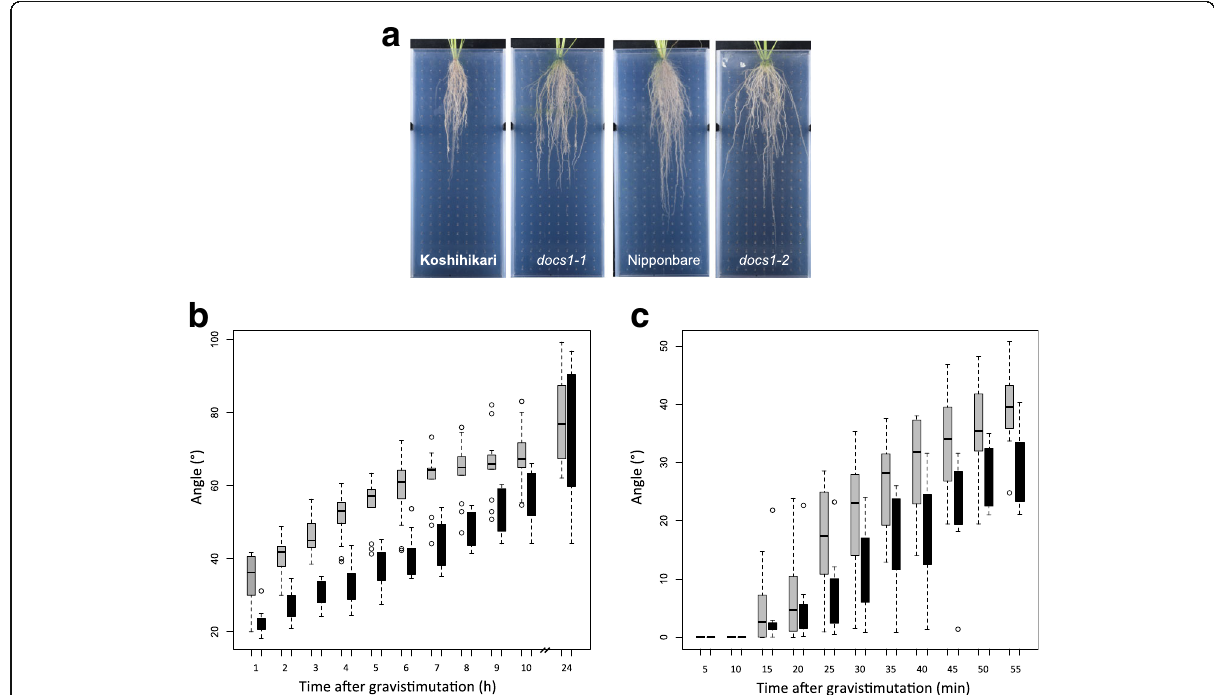
Fig. 3 docs mutants are affected in gravitropic responses. a At 28 days, docs1 mutant plants grown under hydroponic conditions in rhizoboxes (plexiglas plates filled with 5 mm diameter glass beads, see M&M for details) present a larger root cone angle than their respective controls. b , c Gravitropic response of docs1 – 1 mutant (black) is affected compared to Nipponbare control (gray) seedlings. Seedlings have been grown for 3 days in the dark on MS/2 solid medium before rotating the petri dishes of 90°. Radicle angles have been measured every hour for 10 h, and at 24 h ( b , n = 13 for Koshihikari, n = 9 for docs1 – 1 ), and every 5 min for one hour ( c , n = 8 for Koshihikari, n = 7 for docs1 – 1